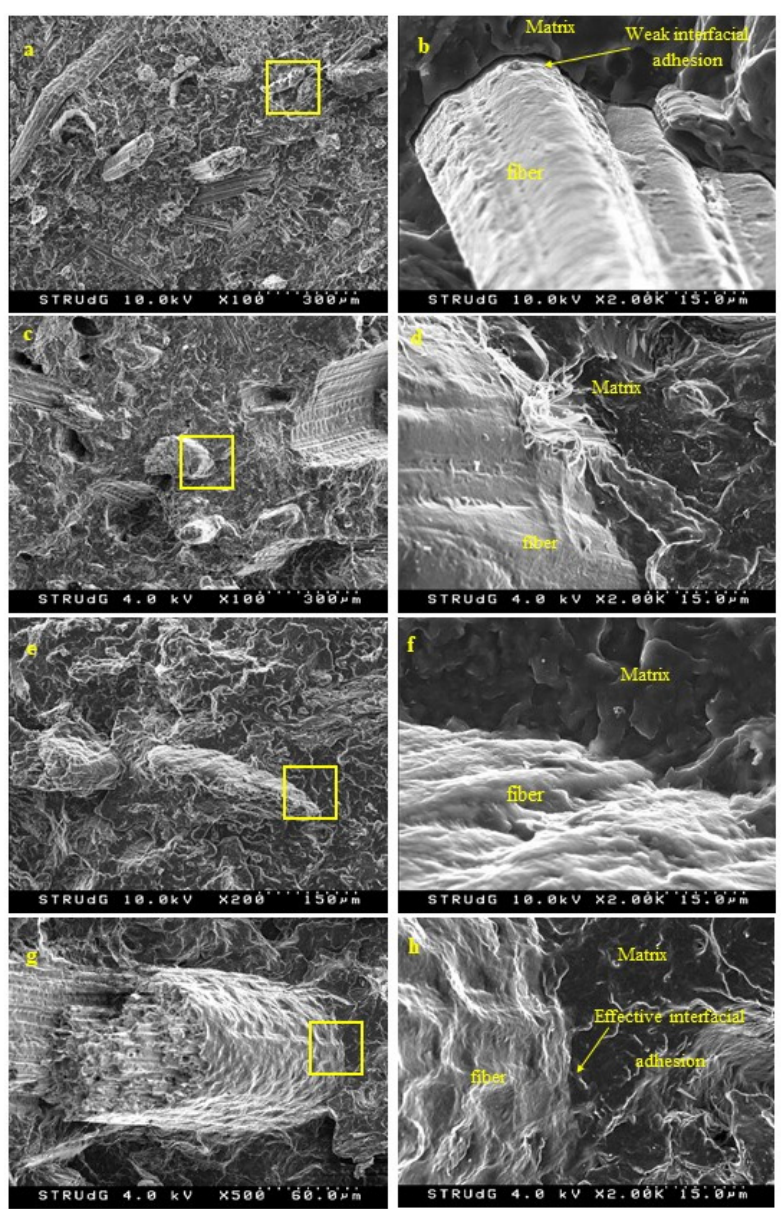
Figure 9. SEM micrograph of the tensile fractured surface for (a,b) DPF ‐ D; (c,d) DPF ‐ D ‐ MAPP; (e,f) DPF ‐ NaOH ‐ MAPP; (g,h) DPF ‐ R ‐ MAPP.